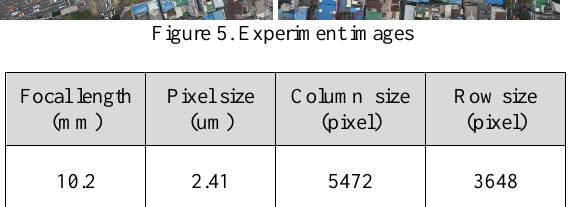
Table 1. Properties of UAV images (IO parameters)